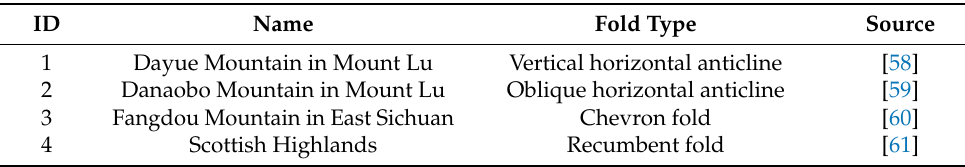
Table 4. Details of each experimental area.